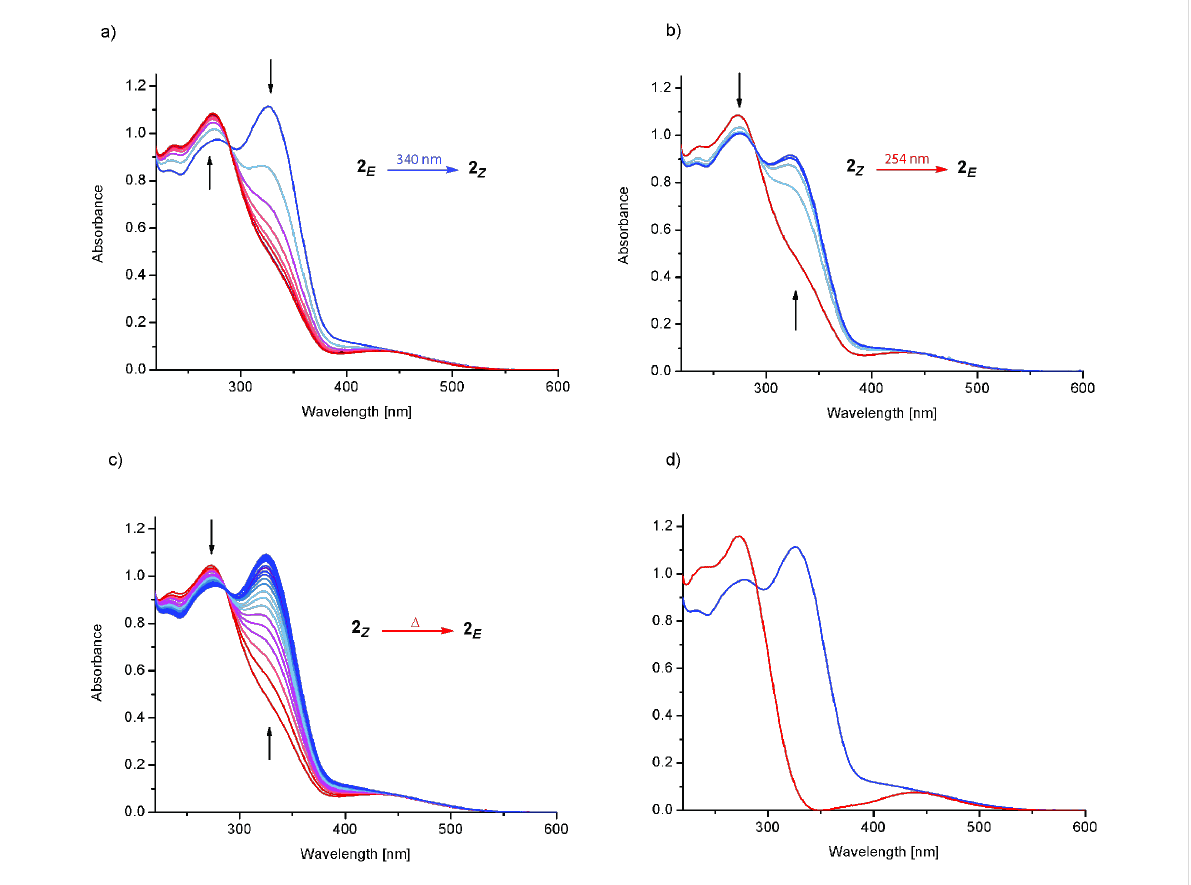
Figure 2: UV–vis spectra of guanidine 2 in acetonitrile, c = 3.9·10 − 5 mol/L. (a) E → Z isomerization with irradiation at 340 nm, 25 °C; (b) Z → E isomer- ization with irradiation at 254 nm, 25 °C; (c) thermal Z → E isomerization at 40 °C; (d) spectra of 2 E (blue) and 2 Z (calculated, red).